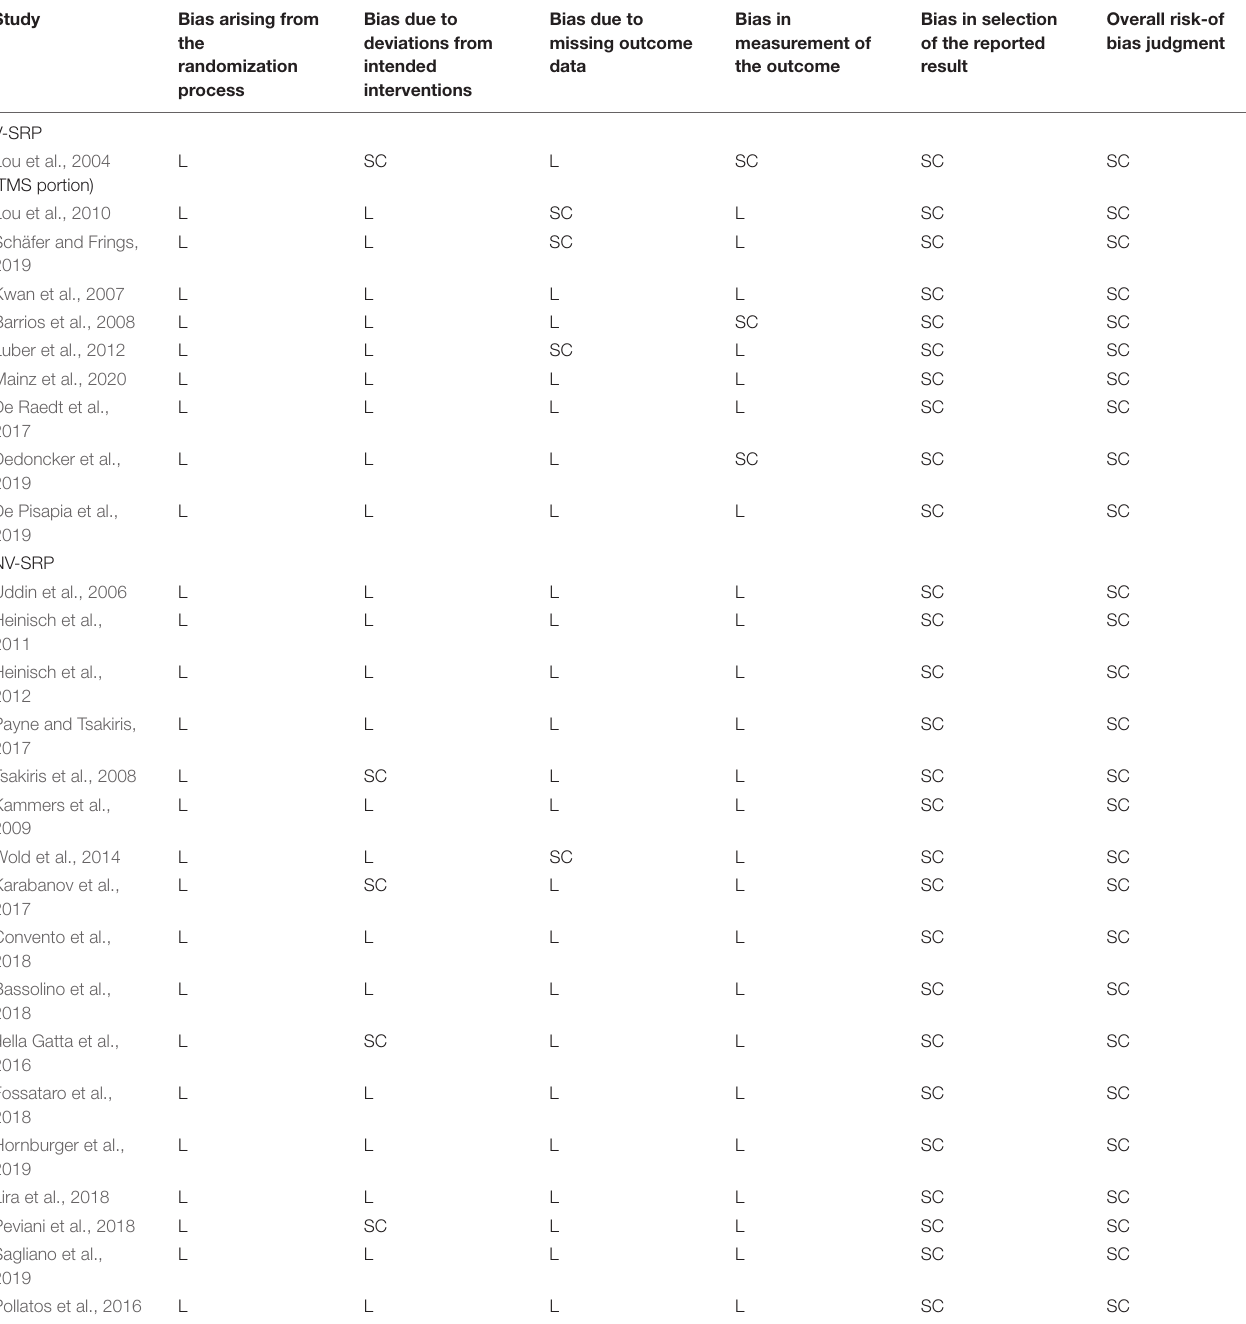
TABLE 5 | Summary of methodological qualities of the included studies.